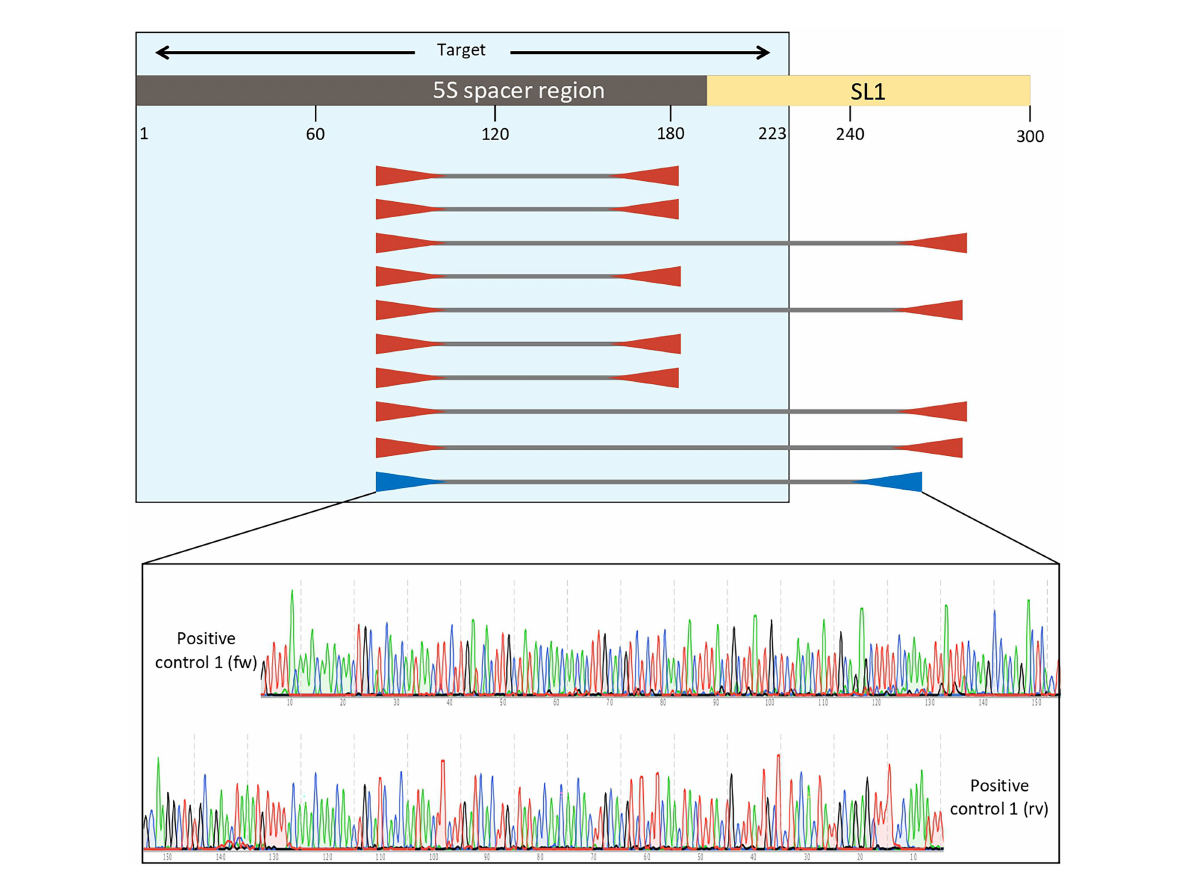
FIGURE 4 Analysis with Primer3plus software using the nucleotides 1–310 of Enterobius vermicularis spacer region. The software generates 10 different options of external primers. The couples first, second, fourth, sixth, and seventh do not include the SL1 sequence, while the others do. Among the latter, the tenth couple was chosen for the external primers because it picked the shorter tract (181 bp, nucleotides 82–263) including the target sequence. Assembled reads from Sanger sequencing of the positive control 1 showing perfect homology with the expected E. vermicularis amplicon with the selected pairs of